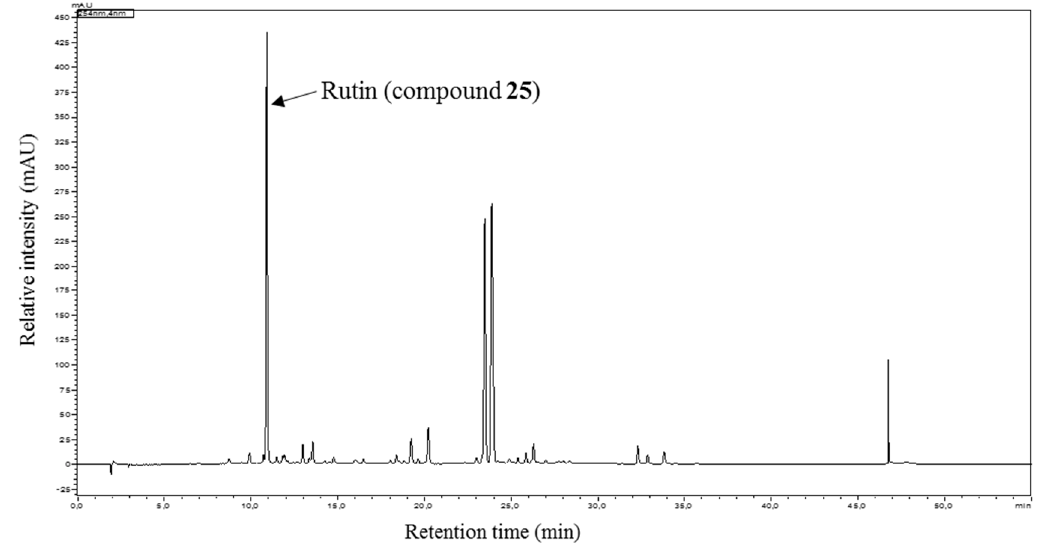
Figure 7. HPLC-DAD chromatogram of methanolic extract of the aerial parts of D. diapensifolia . Analysis condition: stationary phase: Phenomenex Synergi Max-RP C18 4 µm, 150 × 4.6 mm; mobile Phase: A = H 2 O + 0.02% TFA, B = acetonitrile; gradient: 0 min: B = 2%; 20 min: B = 98%; 35 min: B = 98%; T: 35 °C; flow: 1 mL/min; sample concentration and injection volume: 2 mg/mL, 10 µL; detection = 254 nm.